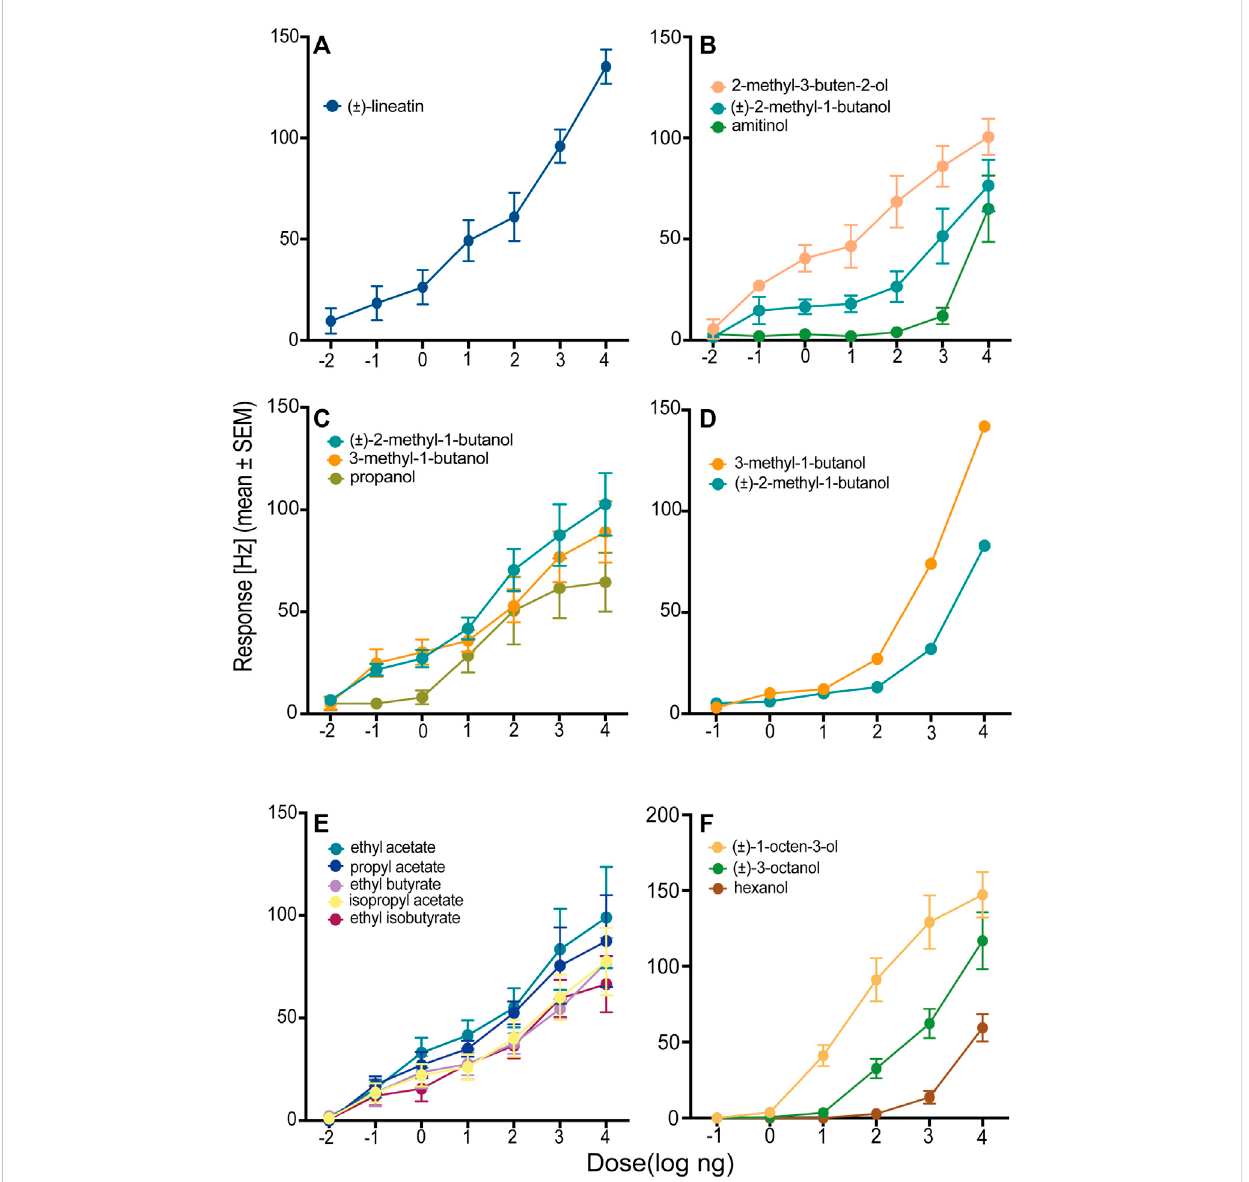
FIGURE 3 Dose – responsecurvesofsix olfactorysensoryneuron(OSN) classesfrom T.lineatum withprimaryresponsesto (A) (±)-lineatin (OSN class1; n =8), (B) 2-methyl-3-buten-2-ol (OSN class 3; n = 4), (C) (±)-2-methyl-1-butanol (OSN class 4; n = 9), (D) 3-methyl-1-butanol (OSN class 5; n = 2), (E) ethyl acetate (OSN class 6; n = 4), and (F) (±)-1-octen-3-ol (OSN class 12; n =